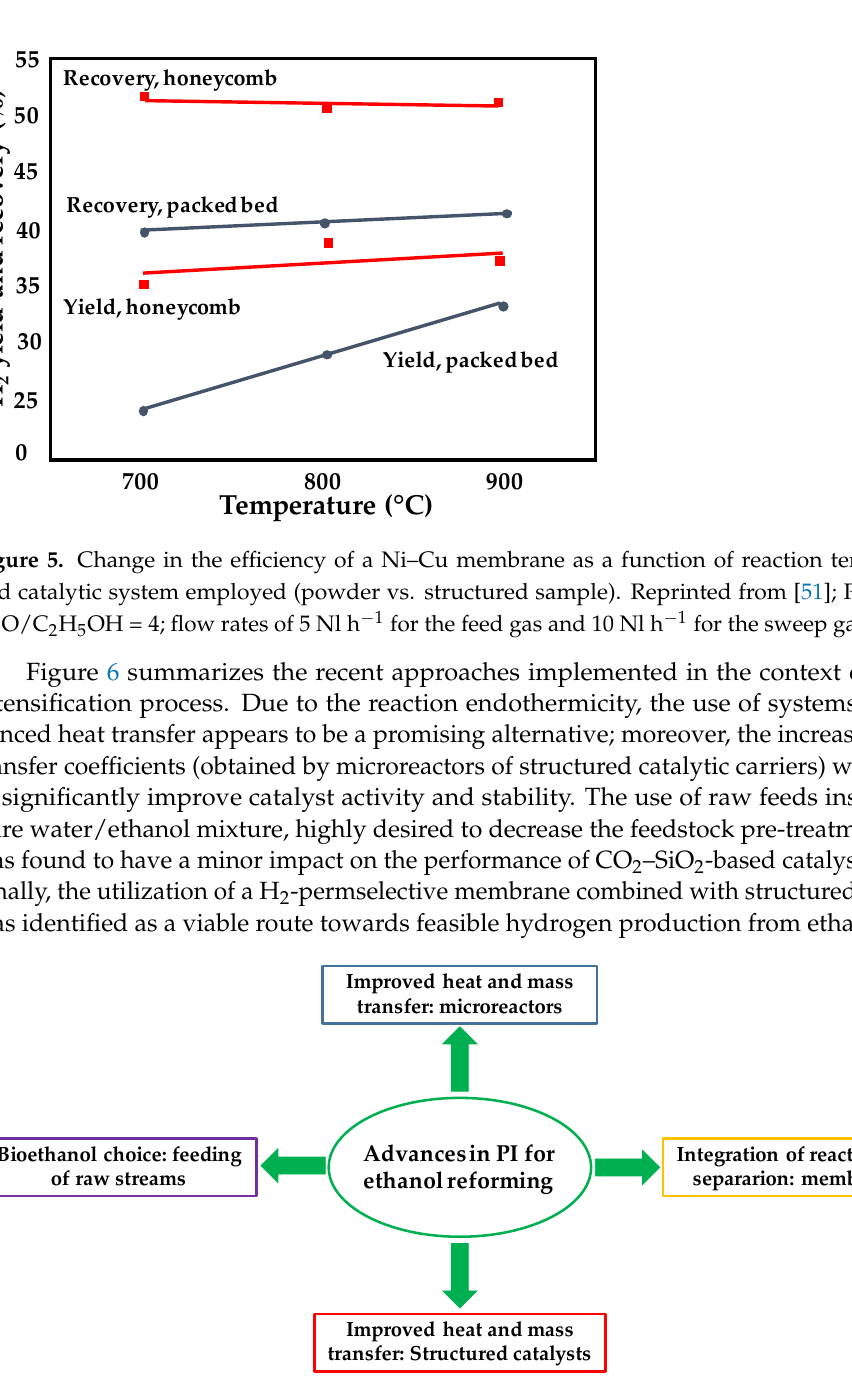
Figure 6. Main strategies followed in the last year for the intensification of ethanol reforming pro- cess.